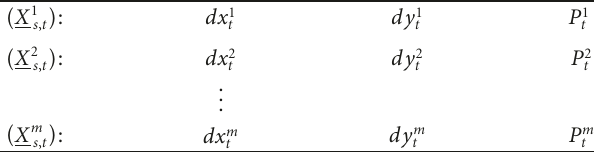
Table 1: GHT table as the model at time t . (cid:2)